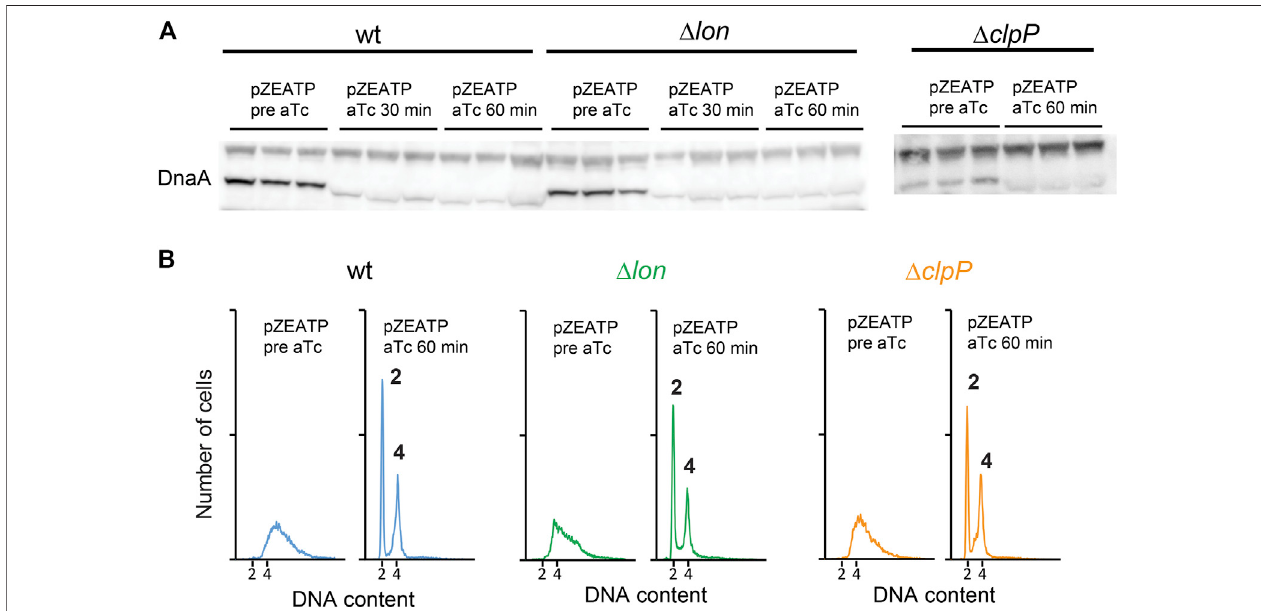
FIGURE 3 | DnaA stability is not affected by ATP-dependent proteases Lon and ClpP. (A) The DnaA protein level prior to and following induction of ATPase in wild type, Δ lon , and Δ clpP grown at 37 ° C in LB. (B) Flow cytometry analysis showing the DNA content of wild type, Δ lon , and Δ clpP prior to and following addition of aTc to induce ATPase expression. Histogram displaying cells 60 min after ATPase induction shows complete replication run out with 2 or 4 fully replicated chromosomes.